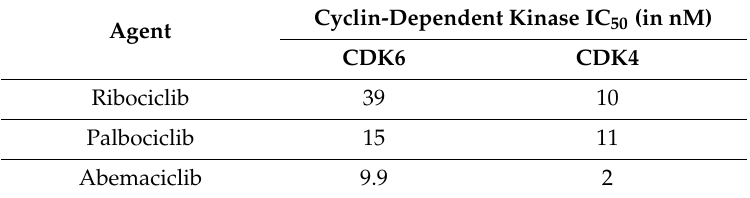
Table 1. The potency of cyclin-dependent kinase (CDK)-inhibitors [15] .